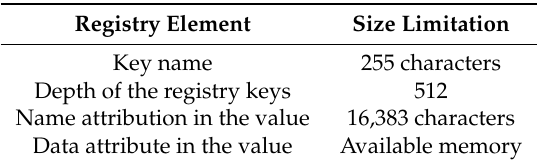
Table 10. Limitations of the Windows registry